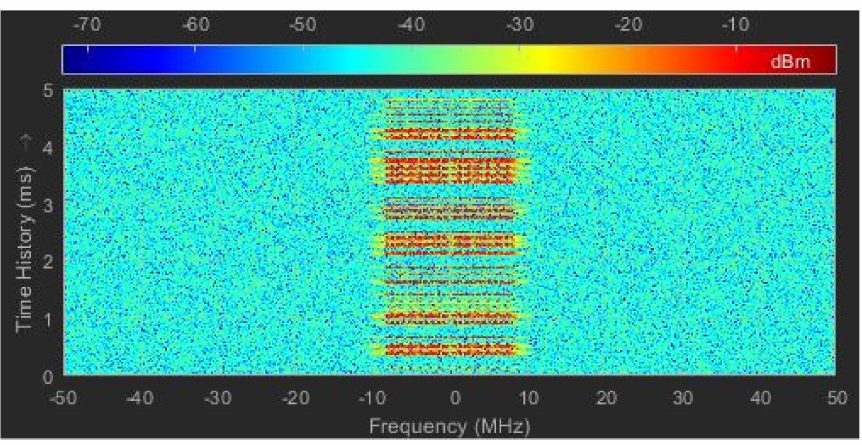
Figure 10. Time − frequency